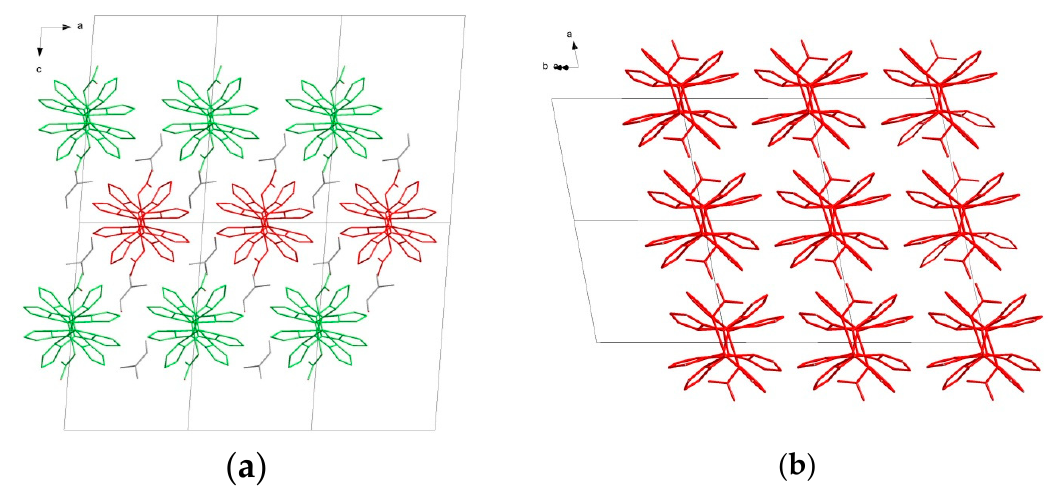
Figure 4. Packing patterns of the polymeric chains of the complexes 1 ( a ) and 2 ( b ).